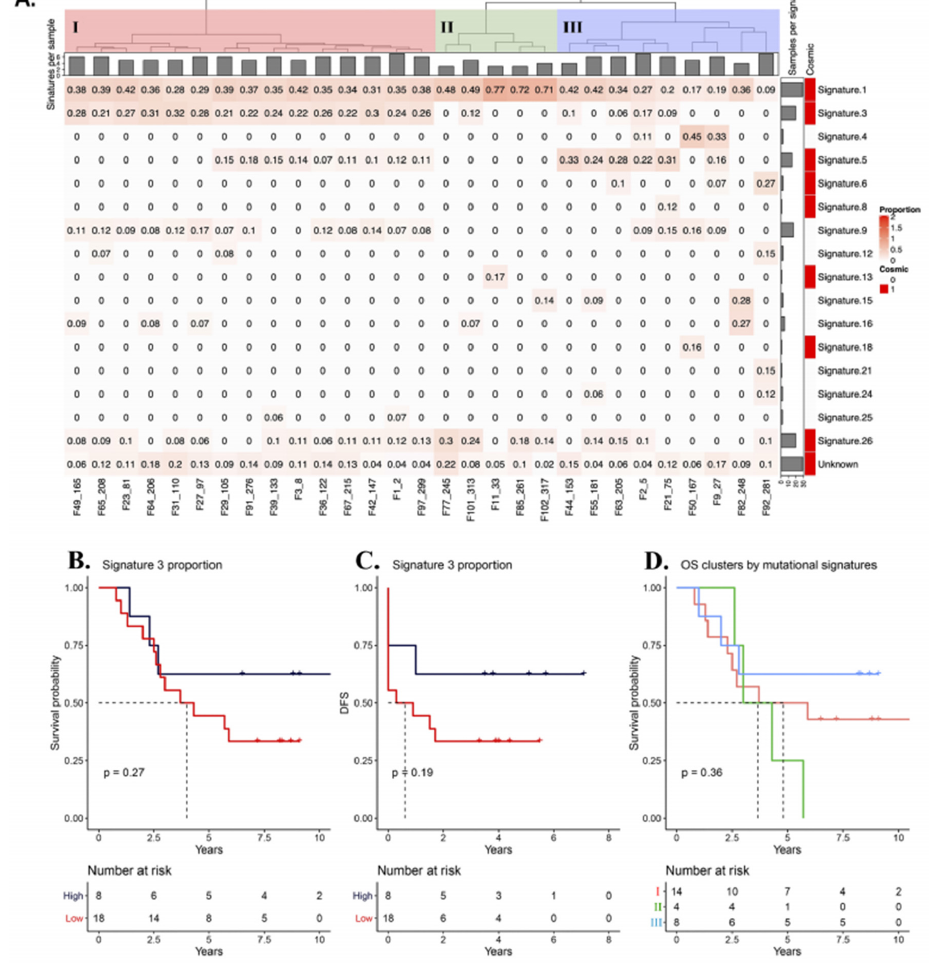
Figure 4. Tumor genomic distribution according to mutational signature profile and overall survival probability of each group. ( A ) Heatmap of the mutational signatures clustered with the Ward’s method (see Materials and Methods section). Three different mutational signature groups were identified and defined as I, II and III. ( B ) Overall survival probability of according to signature 3 proportion (high versus low). ( C ) Disease-free survival probability according to signature 3 proportion (high versus low). ( D ) Overall survival probability of the three mutational signature groups.